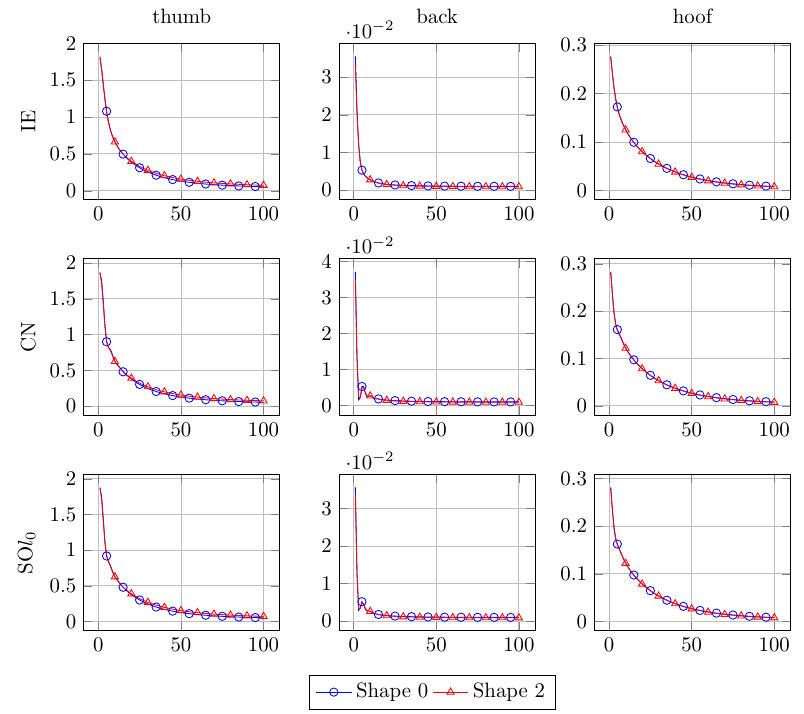
Figure 15. The comparison of the feature descriptors from the centaur shape. We used the damped wave equation ( k = 0.1) with the Gaussian ( σ = 10) initial condition to generate the feature descriptor. Shape 0, Shape 2 and the points are equal to the points, and shapes shown in Figure 1. ( Rows ) Different solvers. ( Columns ) Different